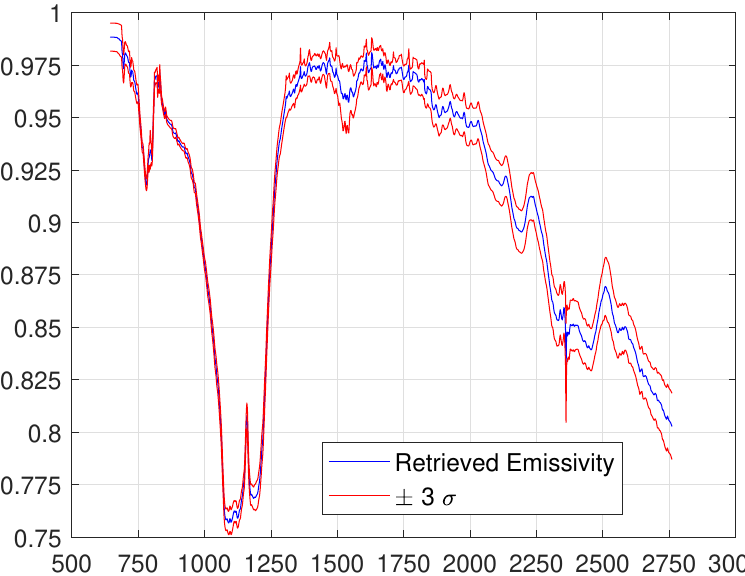
Figure 12. Example of emissivity retrieval for one of the IASI soundings in Figure 2. Its accuracy was calculated as the square root of the diagonal elements of the a posteriori matrix Equation (27).